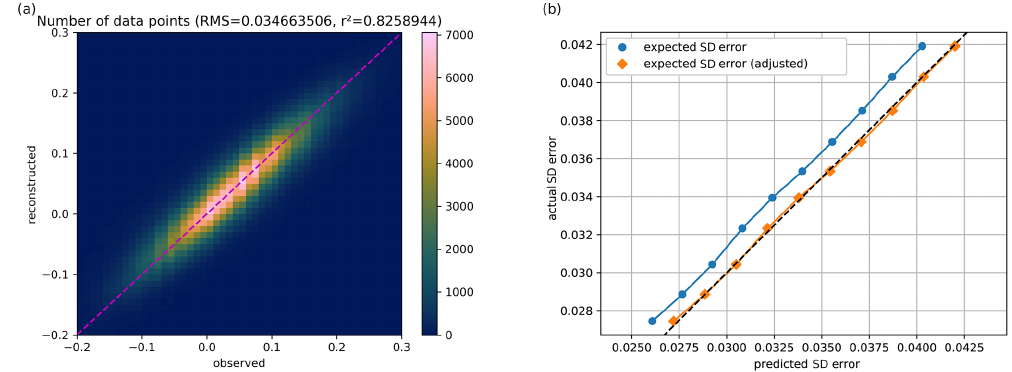
Figure 10. (a) Altimetry observation from the test data versus the reconstructed values from DINCAE with SST as auxiliary parameter (using only the training data). (b) Expected standard deviation of the reconstruction (before and after adjustment) relative to the actual standard deviation of the reconstructed misfit. The x and y axes of both plots are expressed in meters.